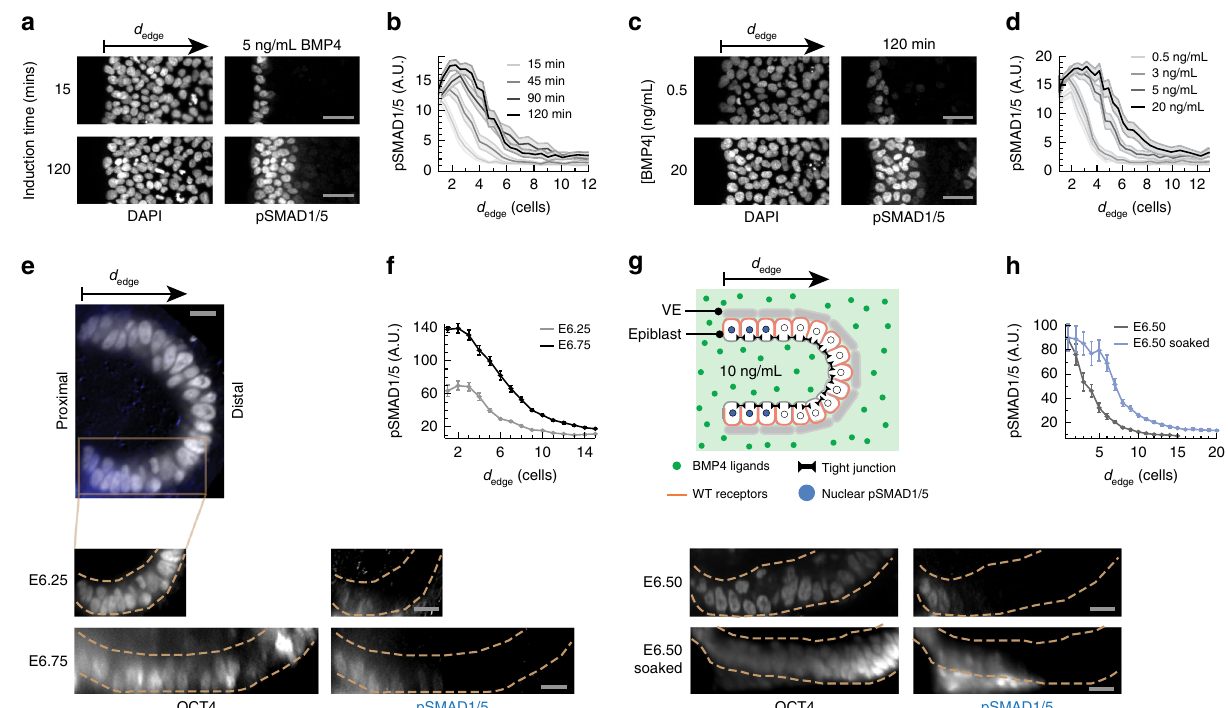
Fig. 5 A robust BMP signaling gradient forms from the epiblast edge. a hESC colony stained for DNA and pSMAD1/5 after 15 or 120 min BMP4 induction. These images are representative of fi ve sets of images from two experiments. b pSMAD1/5 level of single hESCs as a function of their distance from the nearest colony edge, or d edge , after 15 – 120 min of BMP4 induction. c hESC colony stained for DNA and pSMAD1/5 after 120 min exposure to 0.5 – 20 ng/mL BMP4. These images are representative of fi ve sets of images from two experiments. d pSMAD1/5 level of single hESCs as a function of d edge after 120 min exposure to 0.5 – 20 ng/mL BMP4. Shaded error bars denote 95% con fi dence intervals (paired t -test). In hESC data, scale bar 50 µ m. e E6.25 – E6.75 mouse embryos stained for OCT4 (white) and pSMAD1/5 (blue). Dotted yellow lines indicate epiblast boundary. f pSMAD1/5 level of mouse epiblast cells as a function of their distance from the posterior proximal edge of the epiblast, or d edge , for E6.25 (two embryos per experiment) and E6.75 embryos (two embryos per experiment). g Top: Illustration of BMP4 exposure experiment. ExE is surgically removed, and remaining epiblast-VE cup is soaked in media containing 10 ng/mL BMP4 for 30 min. Bottom: Intact E6.5 mouse embryo and BMP4-soaked E6.5 mouse embryo, both stained for OCT4 and pSMAD1/5. Dotted yellow lines indicate epiblast boundary. h pSMAD1/5 intensity of epiblast cells as a function of d edge for intact (three embryos per experiment) and BMP4-exposed E6.5 embryos (two embryos per experiment). In mouse data, error bars denote SEM and scale bar 20 µ